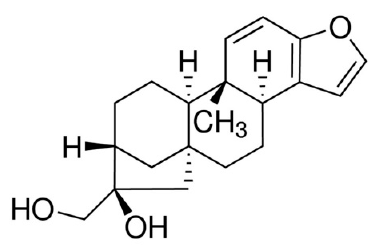
Figure 1. Chemical structure of kahweol.